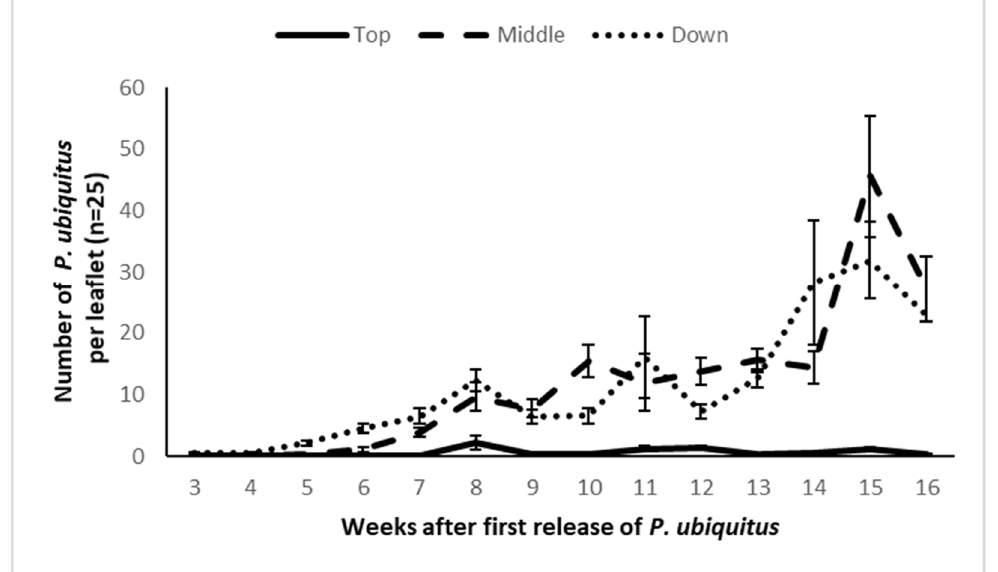
Figure 6. Population dynamics of Pronematus ubiquitus (mean number of mobile mites per leaflet ± SE) in an experimental greenhouse tomato crop.